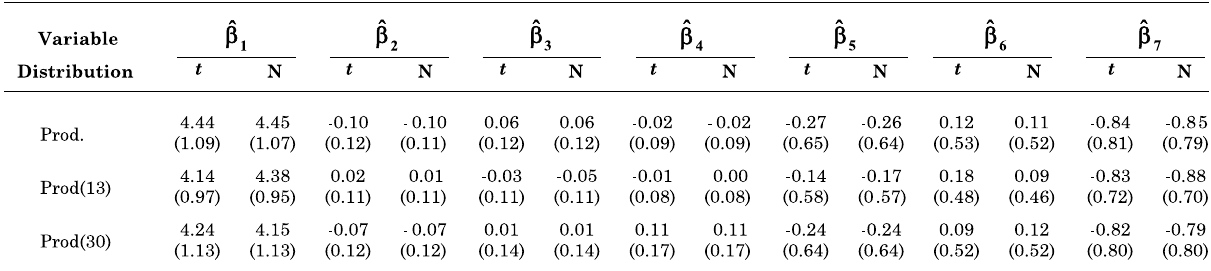
Table 5. Parameters estimated when adopting t -distribution with v = 3 and normal for variables Prod, Prod (13), and Prod (30), using Gaussian (Gaus)